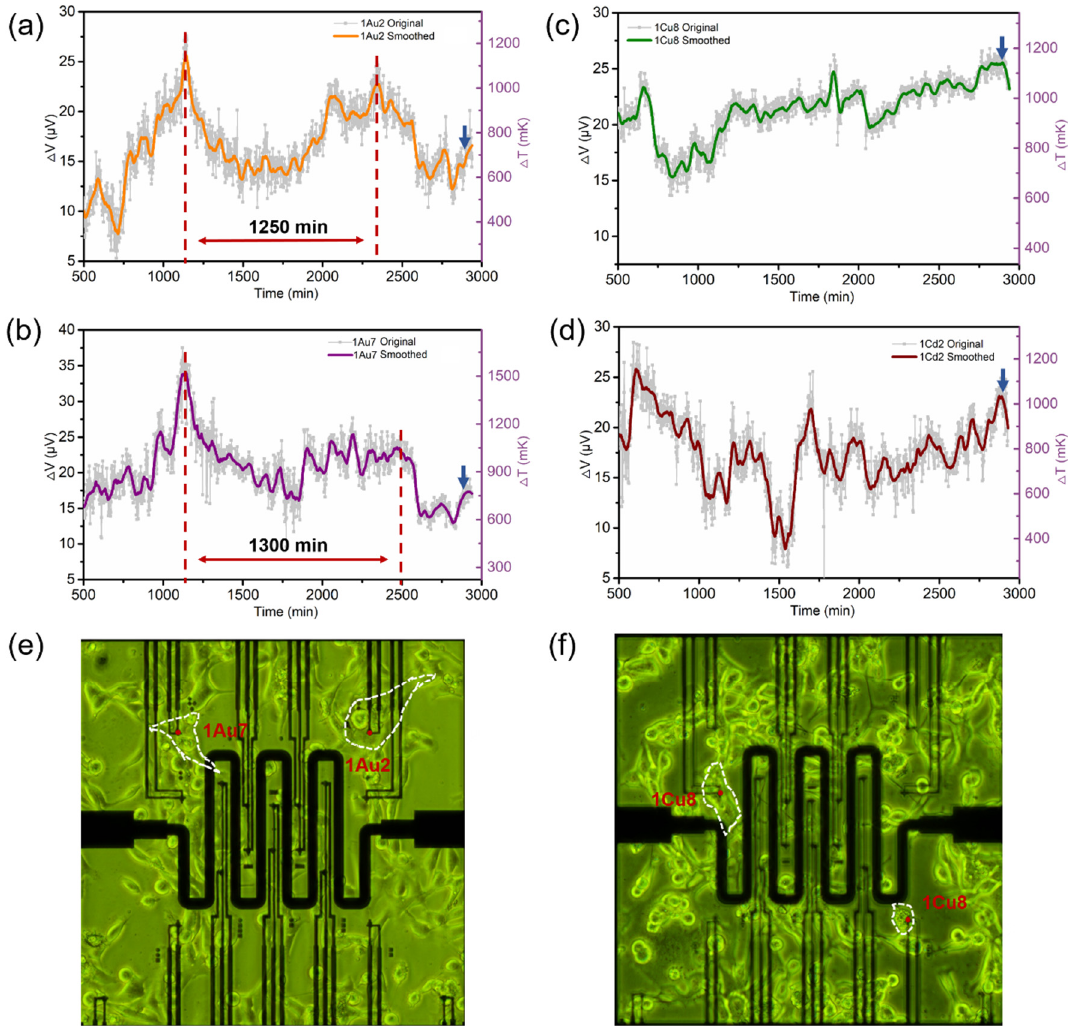
Figure 4. ( a – d ) The absolute temperature fluctuations of the HeLa cells on the four TFTC sensors named 1Au2, 1Au7, 1Cu8, and 1Cd2 in a 37 °C environment after removal of the background thermal noise. The gray curves represent the original measurement data, and the orange, purple, green, and dark red thick curves result from smoothing the original data. ( e , f ) Photos of the relative positions of the under-test cells and the four thermocouple sensors are highlighted by red dots.